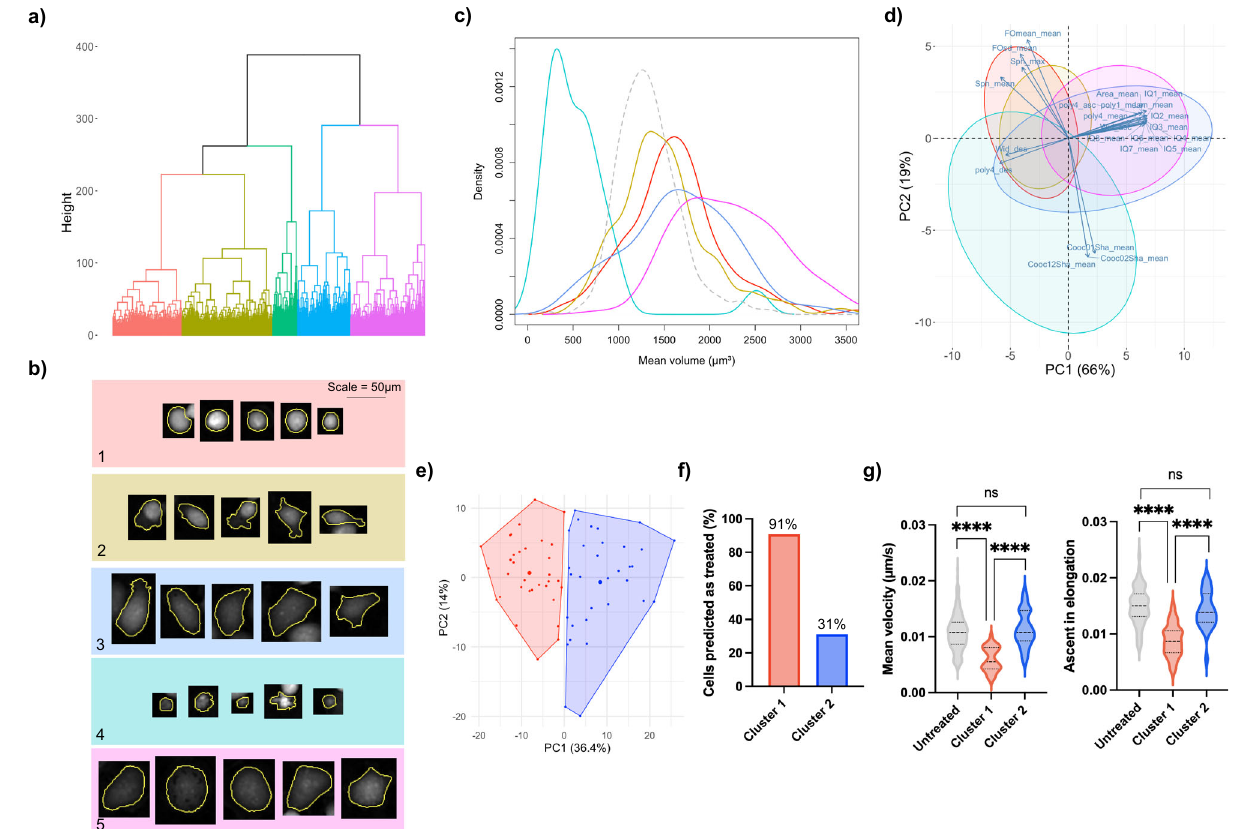
Fig. 6 | Cluster analysis oftreatedcells.a Dendogram obtained from hierarchical clustering of 231Docetaxel treated cells, with 5 clusters coloured. b Examples of cells from each cluster with background colours identifying the cluster, note that thescalebarappliestoallcellimages.Cellswithinaclustersharesimilarproperties but differ to cells in other clusters. c Density plots of mean cell volume, colour- codedaccording tocluster.Thegrey,dasheddensityplotrepresents231Docetaxel untreatedcellsforreference.Cluster4(celldebriscluster)hasthegreatestleftward shift due to cellslosing volume uponcelldeath. Clusters1and 2primarilyspanthe same range of volumes as the untreated set as cells in these clusters have not yet attempted cytokinesis. Clusters 3 and 5 have mean volumes greater than the untreated set as cells in these clusters have continued to grow following failed cytokinesis. d , e k -means clustering of 231Doxorubicin test set treated cells. Cells are colour-coded according to which cluster they were assigned. f The number of cells predicted as treated for each of the clusters. Cluster 1 was formed of suc- cessfully treated cells with 91% (30/33) of cells correctly classi fi ed as treated,